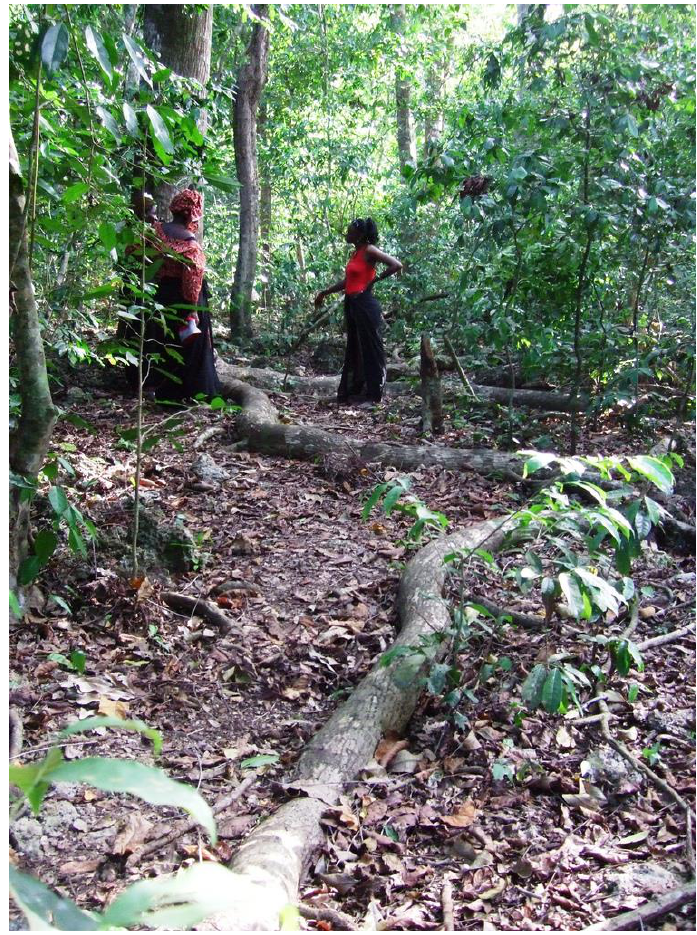
Figure 3. Mijkenda Kaya forests in Kenya (picture from Wikimedia commons, photo by Victor Ochieng @Victor Ochieng ).